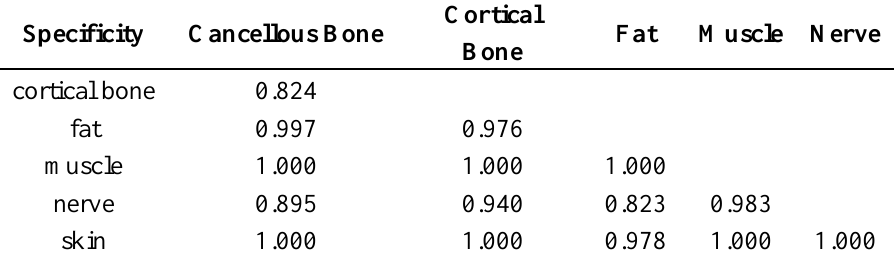
Table 4. Specificity of tissue